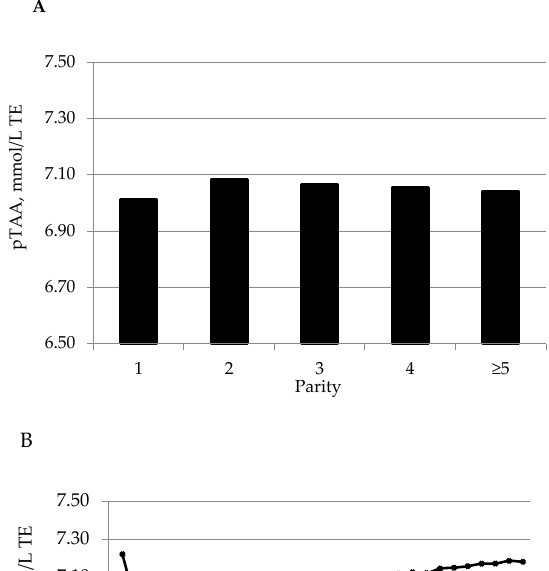
(h 2 ), and repeatability (t) of bovine milk total antioxidant activity. Parameter Estimate SE 0.008 0.001